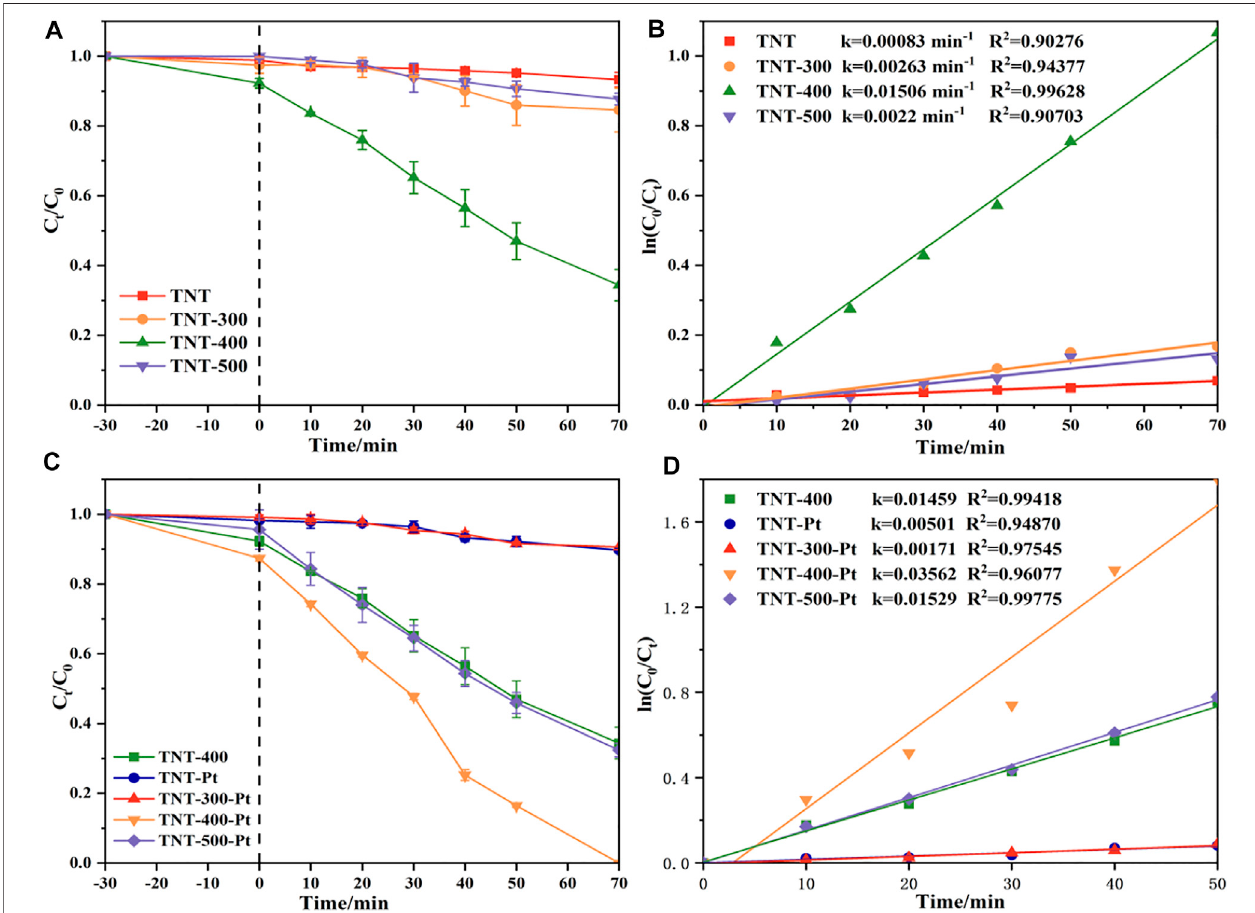
FIGURE 4 | (A) Photocatalytic decomposition of RhB and (B) pseudo- fi rst-order kinetic model by TNT, TNT-300, TNT-400, and TNT-500, (C) photocatalytic decompositionofRhB, and (D) pseudo- fi rst-orderkineticmodelbyTNT-Pt,TNT-300-Pt,TNT-400-PtandTNT-500-Pt,pH=6.83,initialRhBconcentration=20 mg/L.